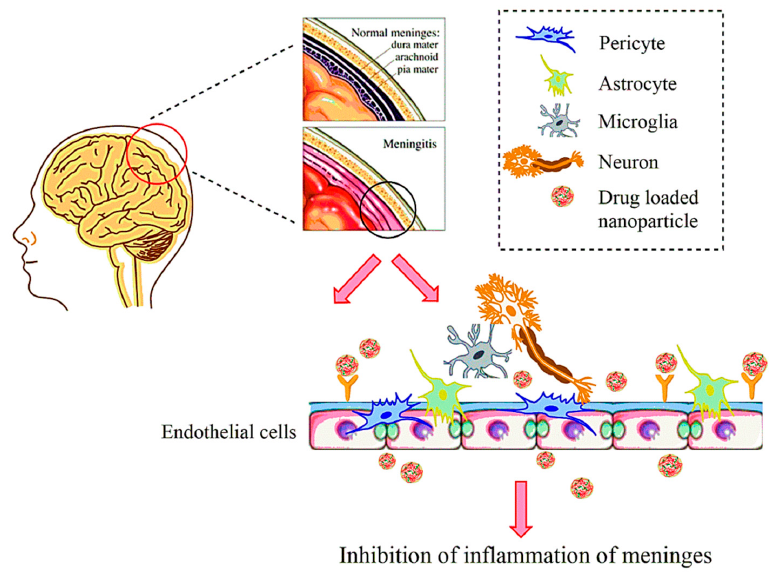
Figure 1. Schematic picture of nanoparticles acting on the endothelial cells of the brain for drug delivery in meningitis.